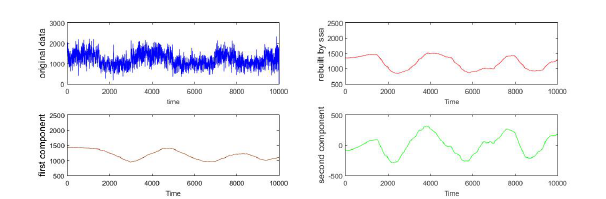
Figure 9. Original data flow, SSA reconstructed data flow, and the first and the second principal components with attack.